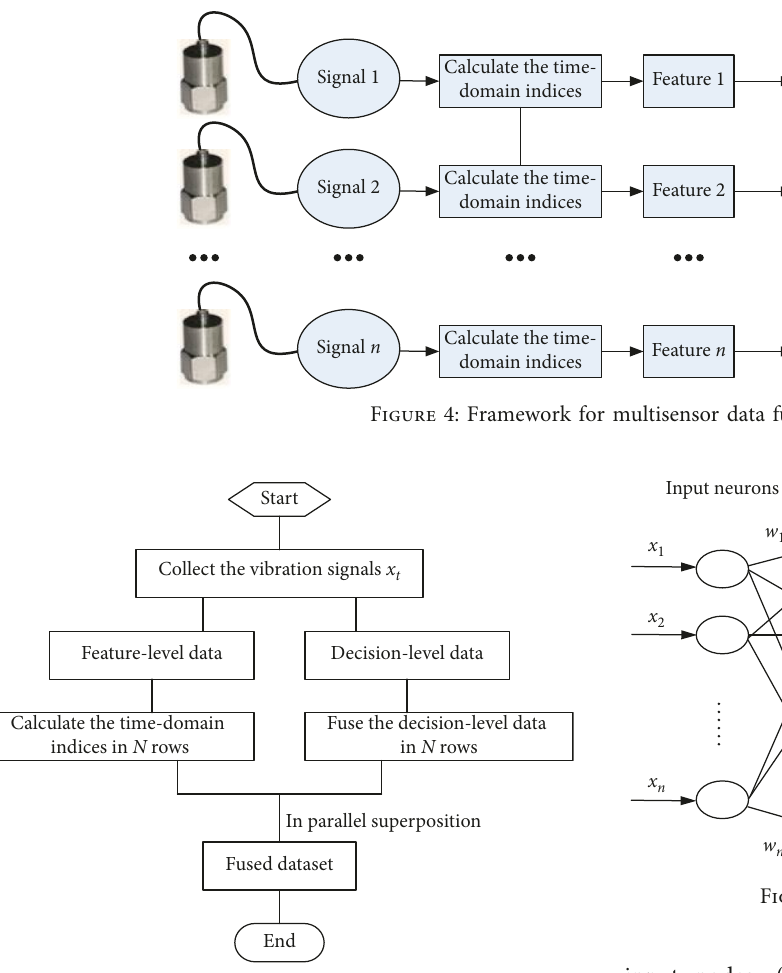
Figure 5: Flow chart of multisensor data